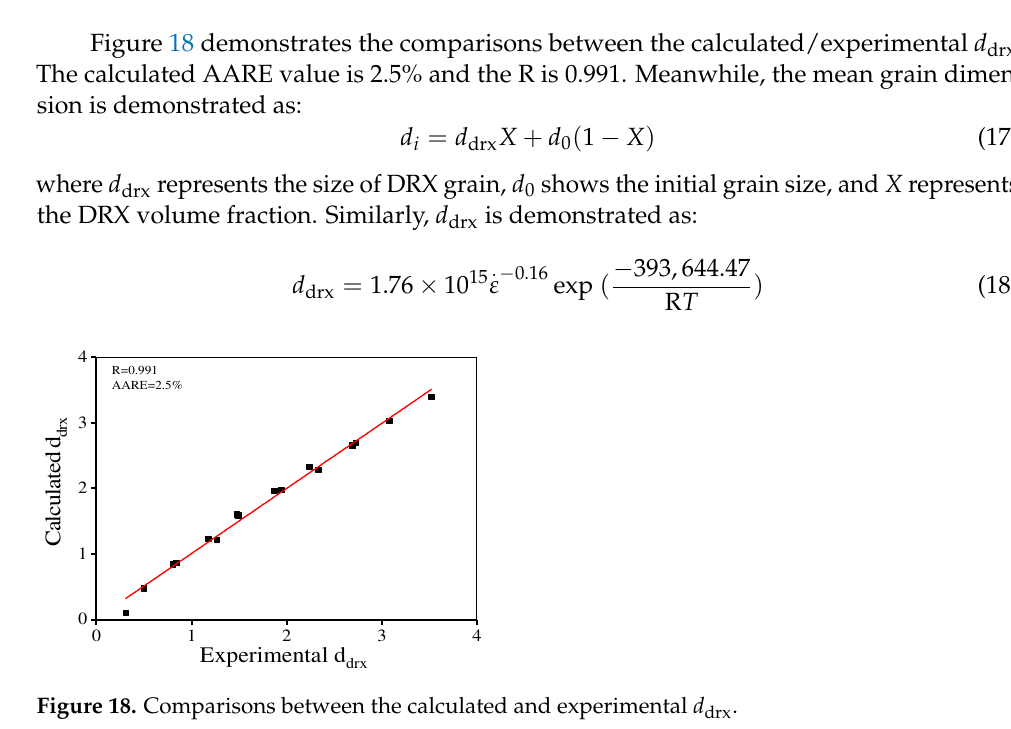
Figure 18. Comparisons between the calculated and experimental d drx .